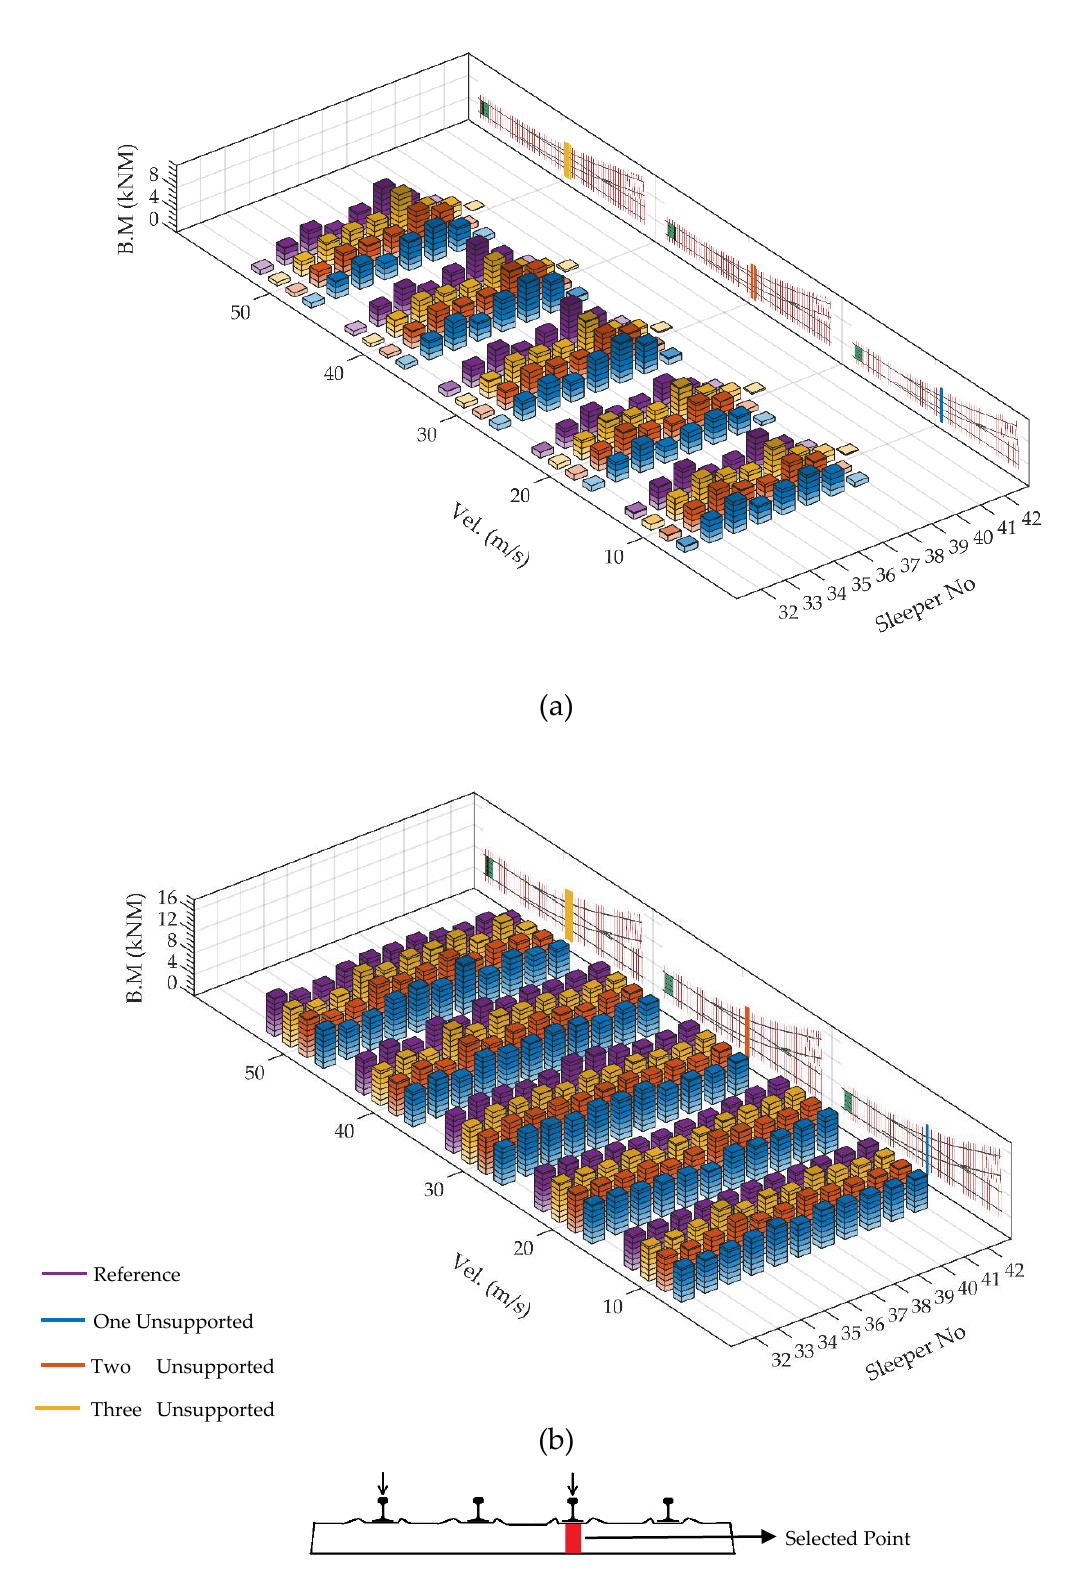
Figure 24. The distribution of positive bending moments over the bearers when unsupported bearers exist at closure panel: (a) at particular time when the front wheel is on the bearer with number 37; (b) when maximum occurs at each bearer.